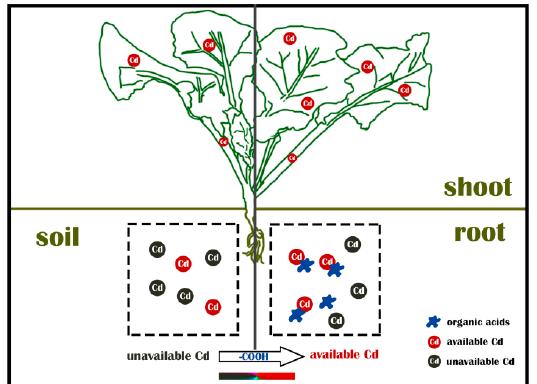
Figure 1. Pattern diagram of organic acids promoting Cd absorption in oilseed rape. In comparison to Cd contaminated soil without application of organic acids ( left ), the addition of organic acids can promote the conversion of unavailable Cd to available Cd so that they enhance the absorption in oilseed